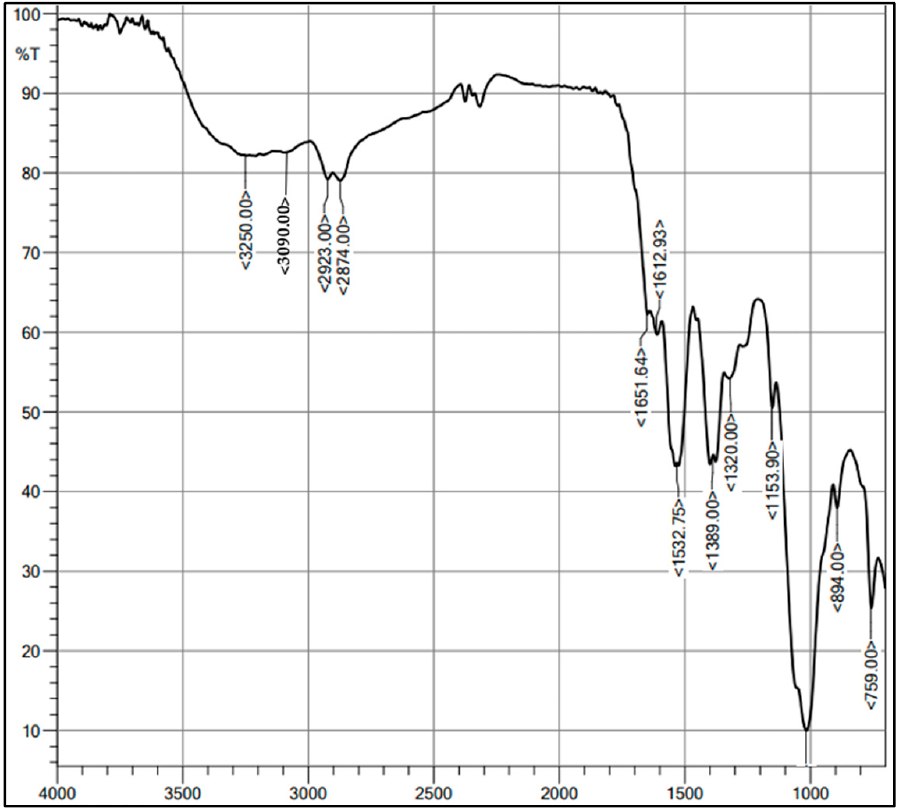
Table 2. Surface elemental analysis of CS-film and CS-MB by EDS (averaged between three different